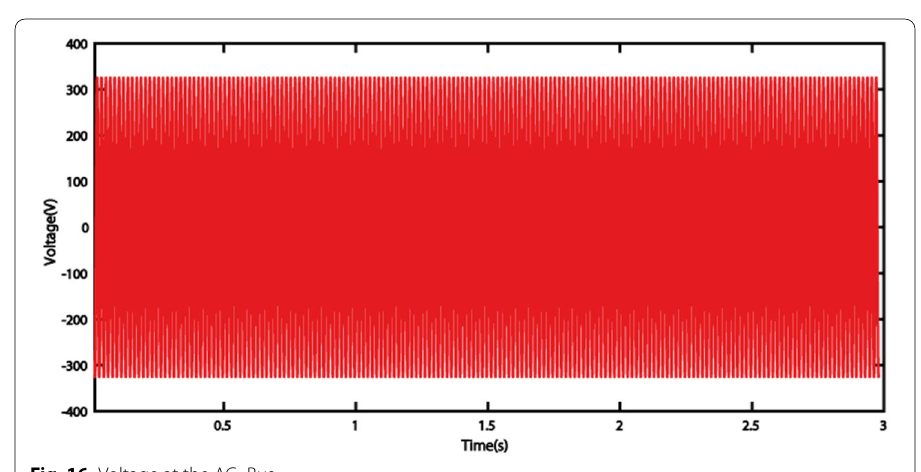
Fig. 16 Voltage at the AC_Bus